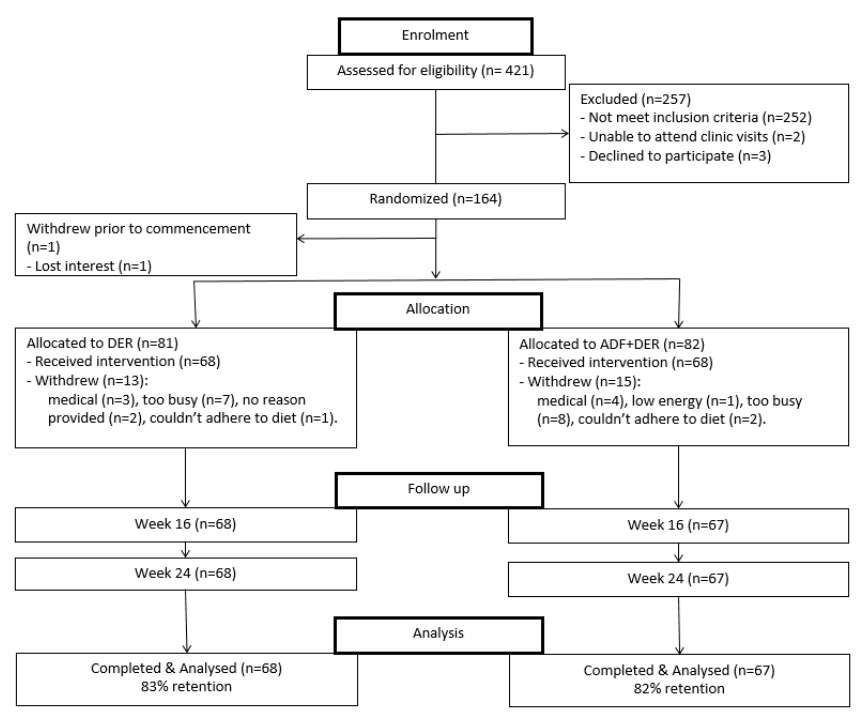
Figure 1. CONSORT diagram indicating sample size at each stage of the study. DER, standard meal replacement program; ADF + DER modified meal replacement program. replacement program; ADF + DER modified meal replacement